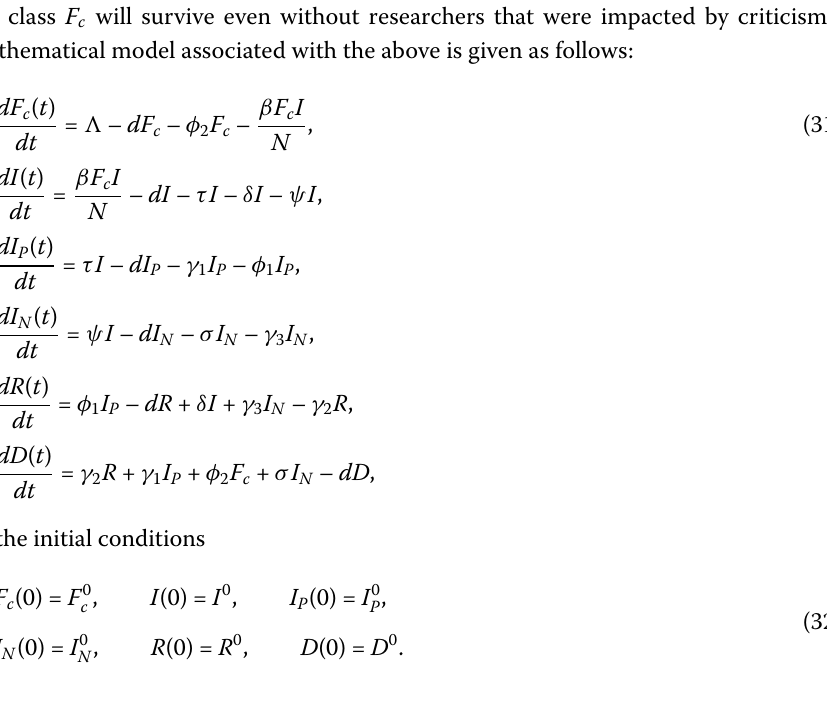
searcher reads a paper with a negative content about nonsingular kernel derivatives. φ 2 is the rate at which a researcher working in fractional calculus joins class D due to division. τ is the rate at which who are affected by criticism, but still have positive opinions about nonsingular kernel derivatives. δ is the recovery rate. ψ is the rate with which a researcher joins I N class, γ 1 is the rate at which individuals with positive opinion join class D due to division. φ 1 is the recovery rate of I P class. σ is the rate at which class I N joins class D due to division. γ 3 is the recovery rate of class I . γ 2 is the recovery rate of class D . In the Fig. 1, we present a mathematical diagram depicting the dynamic